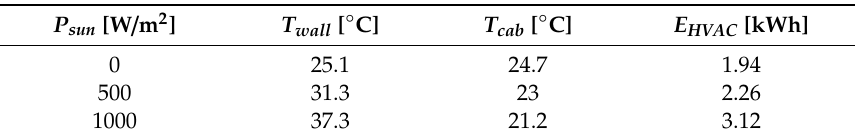
Table 4. Cabin temperature, wall temperature and consumed energy for ideal comfort (PMV=0) for different solar radiations.